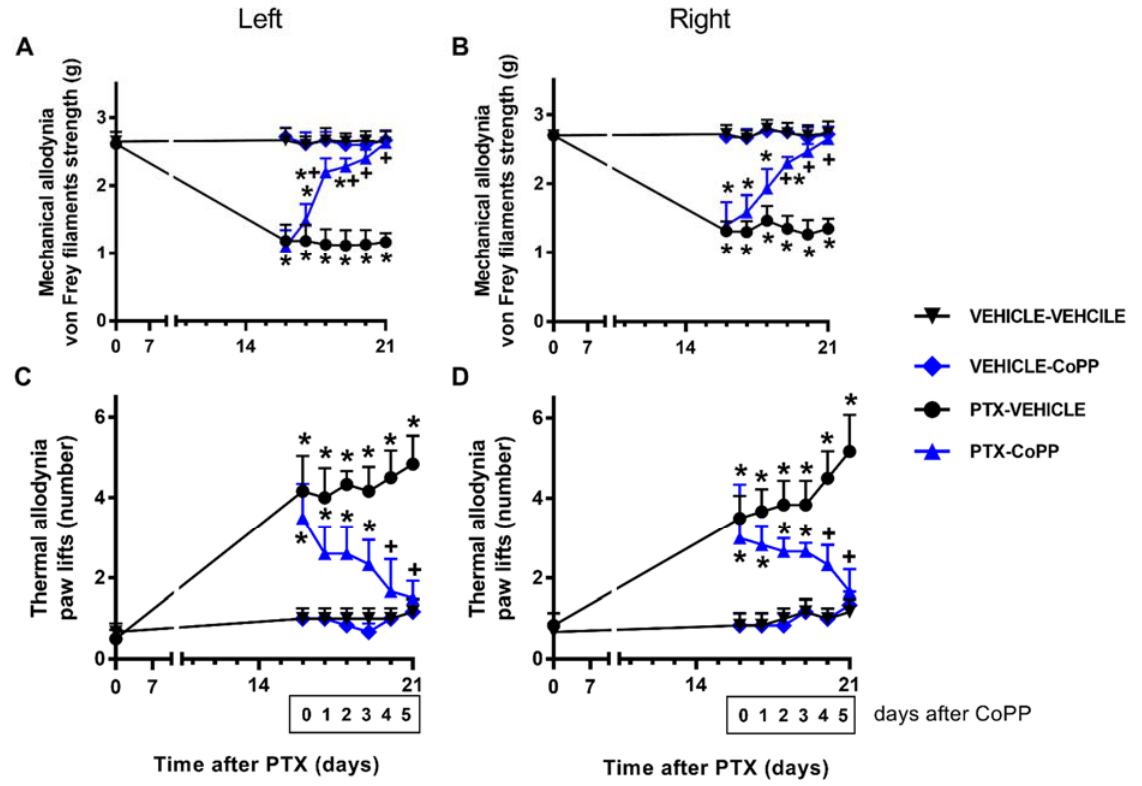
Figure 2. Effects of CoPP on PTX-induced mechanical and cold allodynia. Mechanical ( A : left paws; B : right paws) and cold ( C : left paws; D : right paws) antiallodynic effects produced by the repeated administration of 5 mg/kg of CoPP or vehicle for five days from days 17 to 21 after PTX injection. In all panels, for each day and treatment evaluated, * indicates significant differences vs. the vehicle– vehicle-treated animals and + vs. PTX–vehicle-treated animals ( p < 0.05, one-way ANOVA followed by the SNK test). Results are shown as mean values ± SEM; n = 6 animals per experimental group.